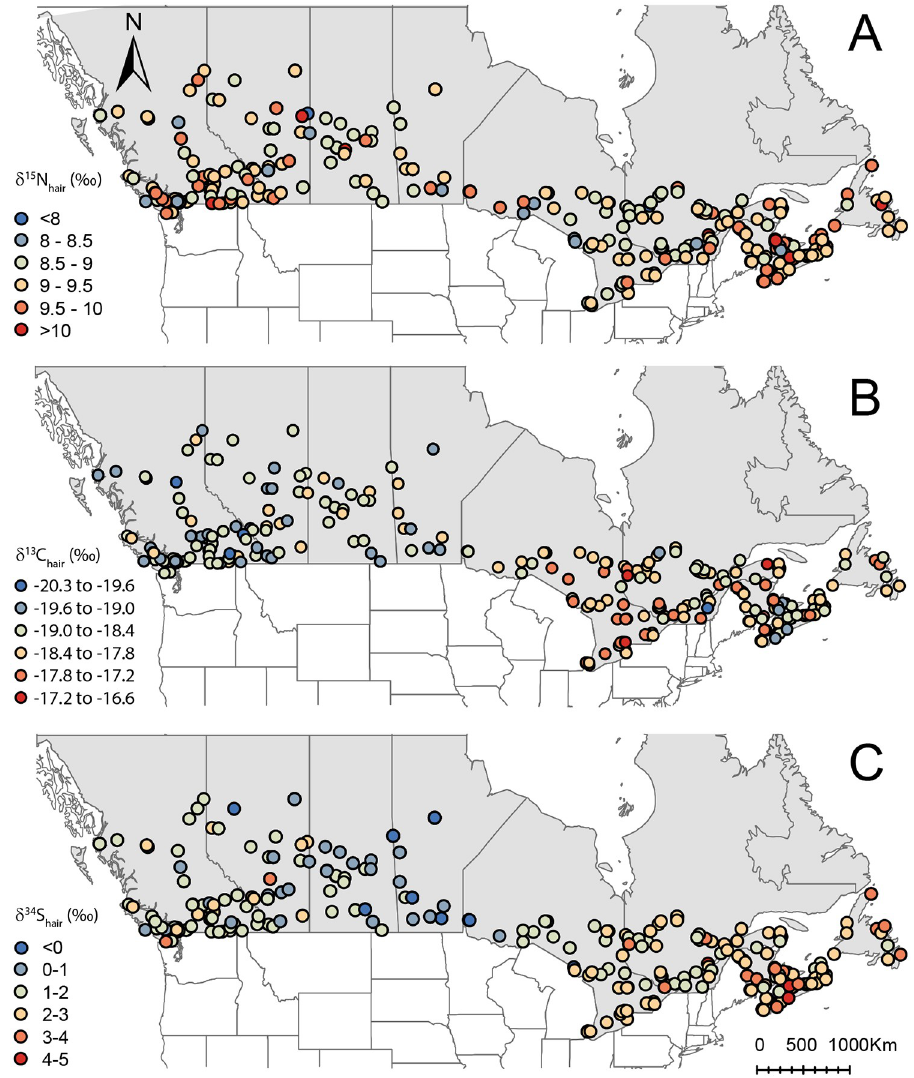
Fig 2. Distribution of sample locations and isotopic values in hair across Canada. A. Nitrogen isotope variations (n = 577). B. Carbon isotope variations (n = 577). C. Sulphur isotope variations (n = 549). Administrative boundaries are from http://www.naturalearthdata.com/. This map was generated in Rx64 3 4.2 (https://www.r-project.org/).